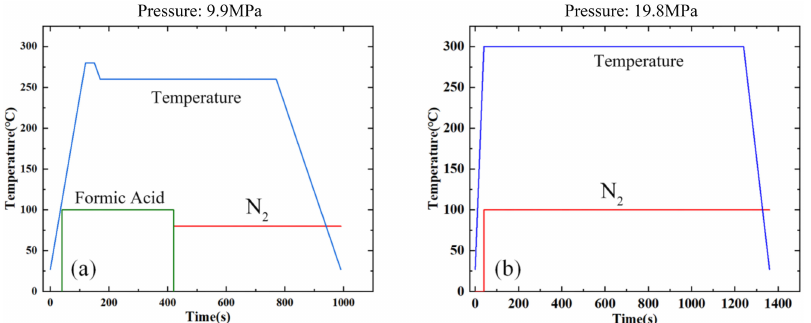
Figure 6. Bonding conditions. ( a ) Cu–Sn bonding. ( b ) Au–Au